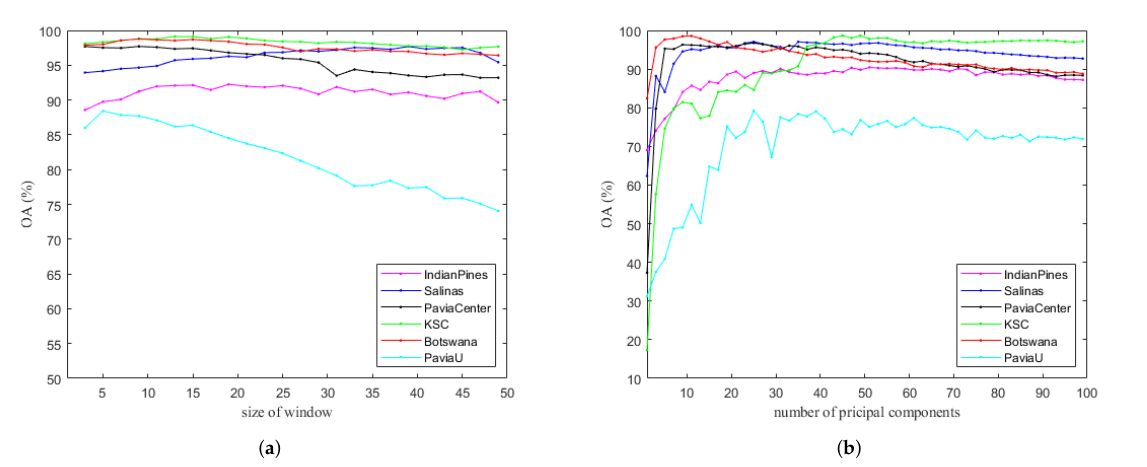
Figure 11. Influence of parameters in the pre-processing stage on six datasets. ( a ) OA versus window size ω ; ( b ) OA versus number of principal components d .